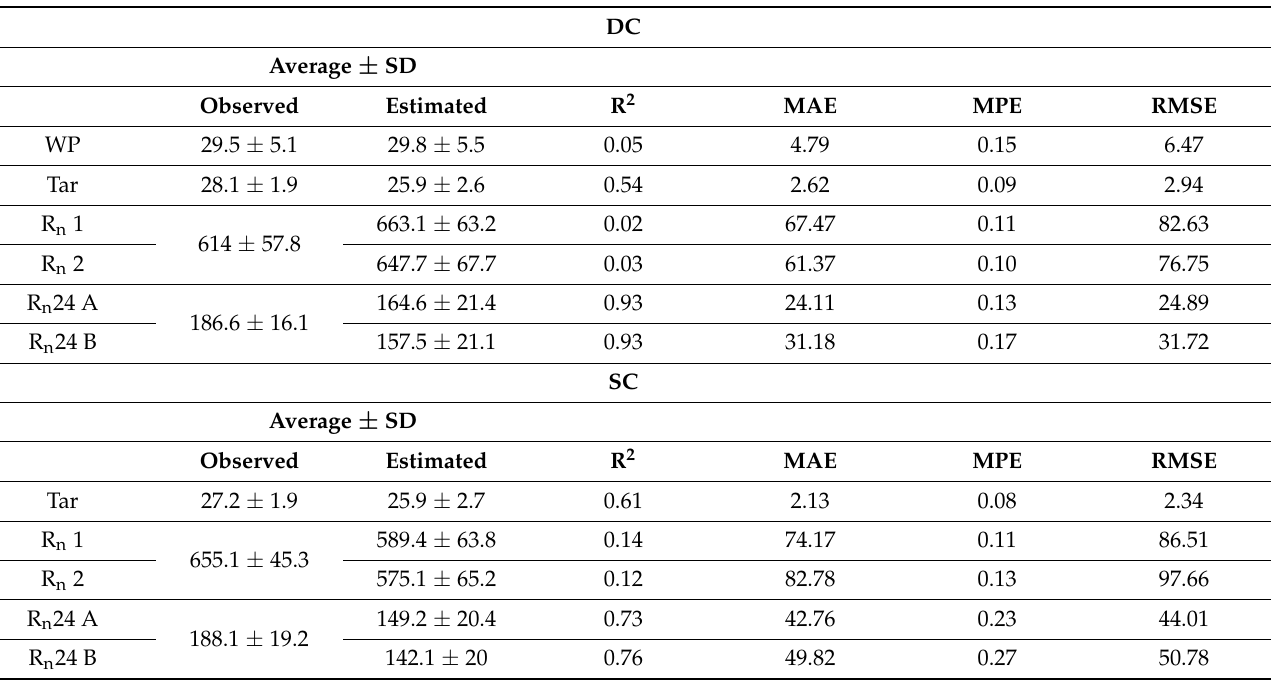
Table 1. Statistical analyzes for Precipitable Water (WP) in mm, Air Temperature (Tar), in ◦ C, Instantaneous Net Radiation (R n 1 and R n 2), in W · m − 2 , and Daily Net Radiation (R n 24 A and R n 24 B), in W · m − 2 , for the year 2013 in the DC and SC areas.